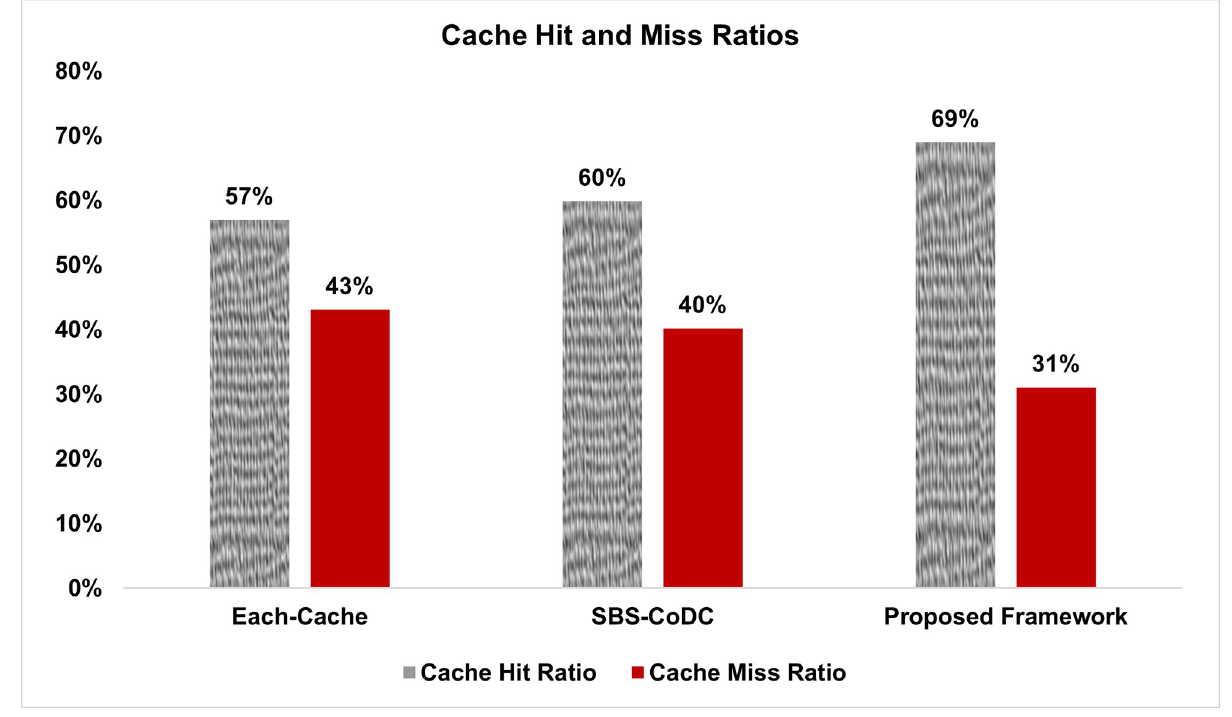
Fig 5. Comparison average cache hit and miss